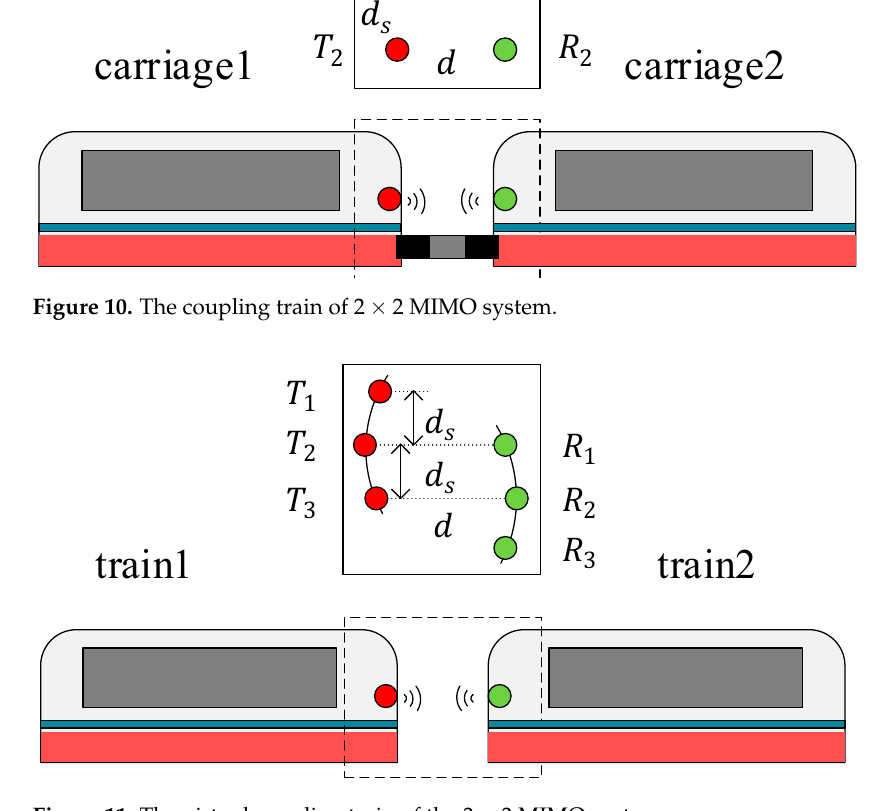
Figure 11. The virtual coupling train of the 3 × 3 MIMO system.